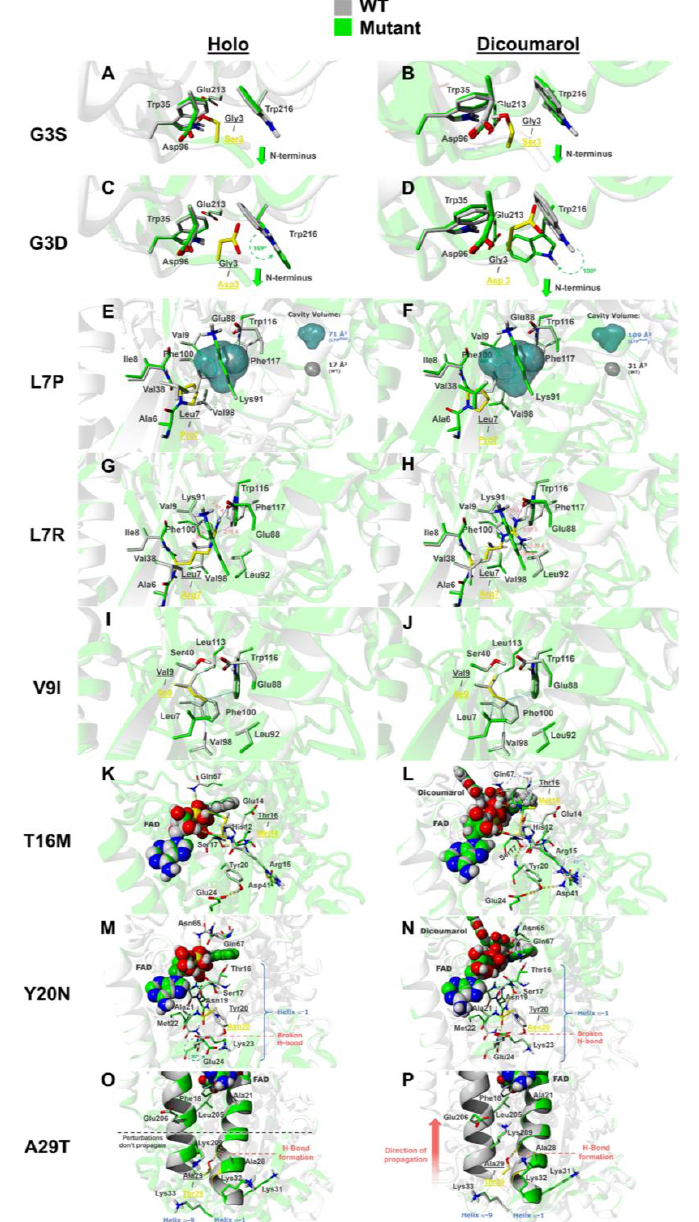
Figure 7. Overview of the mutational effects from in silico mutagenesis. Gray-colored amino acids represent the WT structure while green-colored amino acids represent the mutated models. Mutated residues are shown as sticks colored in yellow for each case. ( A , B ) NQO1 holo ( A ) and NQO1 dic ( B ) states with the G3S mutation. Green arrows indicate displacement of the N-terminus on the opposite side of the mutation. ( C , D ) NQO1 holo ( C ) and NQO1 dic ( D ) states with the G3D mutation. Green dashed arrows indicate side chain rotation. ( E , F ) NQO1 holo ( E ) and NQO1 dic ( F ) with the L7P mutation. Blue and gray surfaces represent cavities in the protein core for the mutant and WT, respectively. ( G , H ) NQO1 holo ( G ) and NQO1 dic ( H ) with the L7R mutation. Clashes are shown as blue solid lines marked with inter-atomic distances. ( I , J ) NQO1 holo ( I ) and NQO1 dic ( J ) with the V9I mutation. Hydrophobic